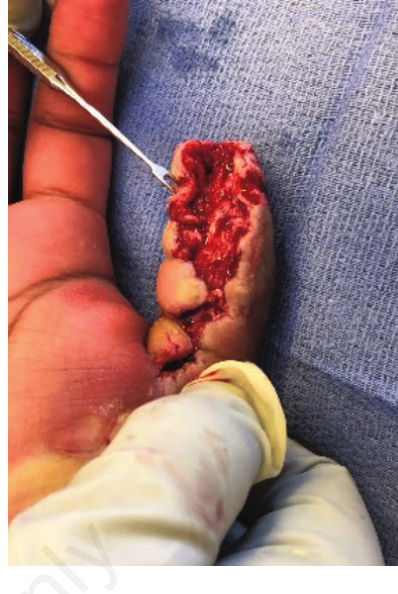
Figure 2. Intraoperative image of the right thumb at the third operation showing extensive damage to the volar soft tissues from the injection injury and